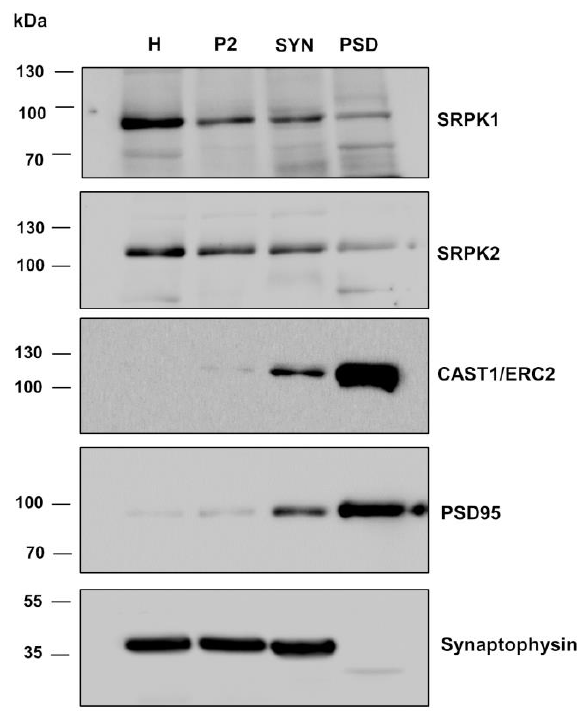
Figure 9. Endogenous SRPK1 and SRPK2 associate with synaptic brain fractions. Adult rat brains were homogenized and fractionated (see methods). Thirty micrograms of protein of each fraction were fractionated by SDS-PAGE. Western blots were probed with antibodies against SRPK1, SRPK2, SRPK3, CAST1 / ERC2, synaptophysin and PSD95. PVDF membranes were stripped and reprobed to analyze all proteins. Molecular-weight size markers standards are shown on the left. H, homogenate; P2, crude membranes; Syn, synaptosomes; PSD, postsynaptic density (images represent three independent experiments).